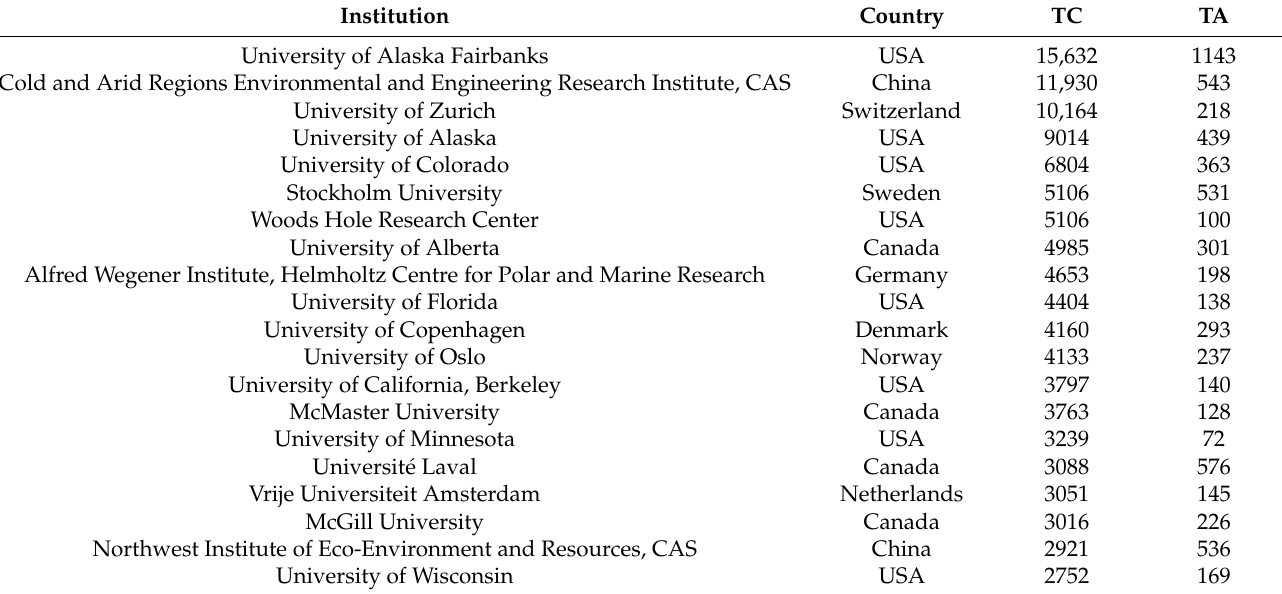
Table 3. Top 20 institutions, ranked by total citations in permafrost